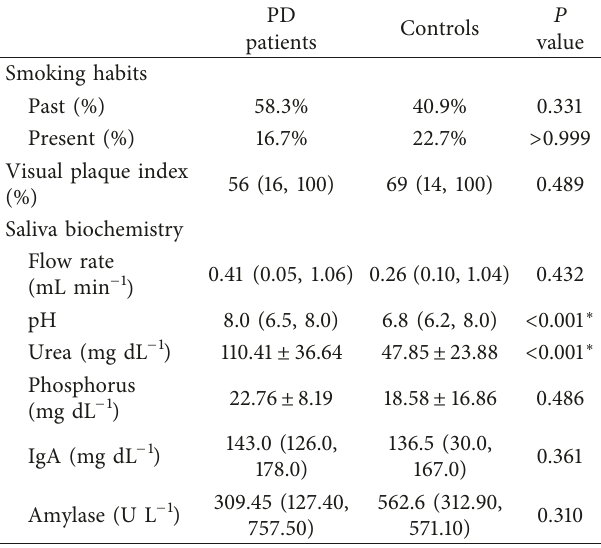
Table 4: Smoking habits, oral hygiene, and saliva biochemistry of peritoneal dialysis (PD) patients and controls.